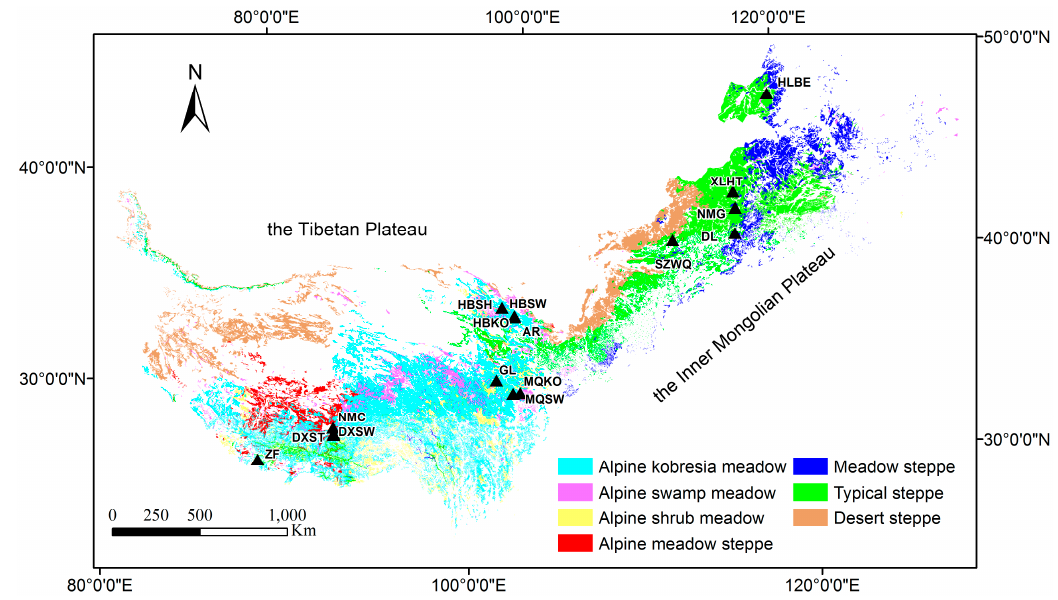
Figure 1. Map showing the spatial distribution of the alpine and temperate grasslands in China. Triangles denote the 16 flux-tower sites. DXST = DangXiong alpine meadow steppe; DXSW = DangXiong alpine swamp meadow; HBSW = HaiBei alpine swamp meadow; HBSH = HaiBei alpine shrub meadow; HBKO = HaiBei alpine Kobresia meadow; MQSW = MaQu alpine swamp meadow; MQKO = MaQu alpine Kobresia meadow; ZF = ZhuFeng; NMC = NaMuCuo; GL = GuoLuo; AR = ARou; NMG = NeiMengGu; XLHT = XiLinHaoTe; SZWQ = SiZiWangQi; HLBE = HuLunBeEr; DL = DuoLun.